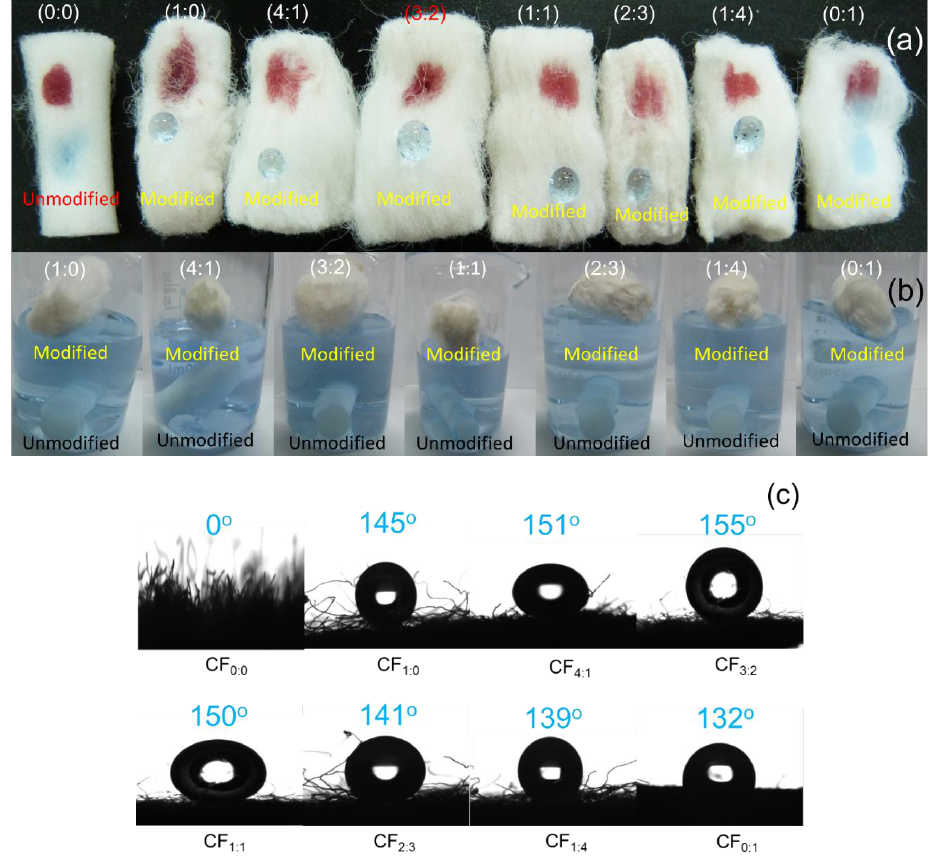
Figure 4. Optical images of water and oil droplets on unmodified and modified CF ( a ), soaking in water ( b ) and water contact angle ( c ). Droplets of water (blue) and silicone oil (red) were colored with bromophenol blue and Sultan three,